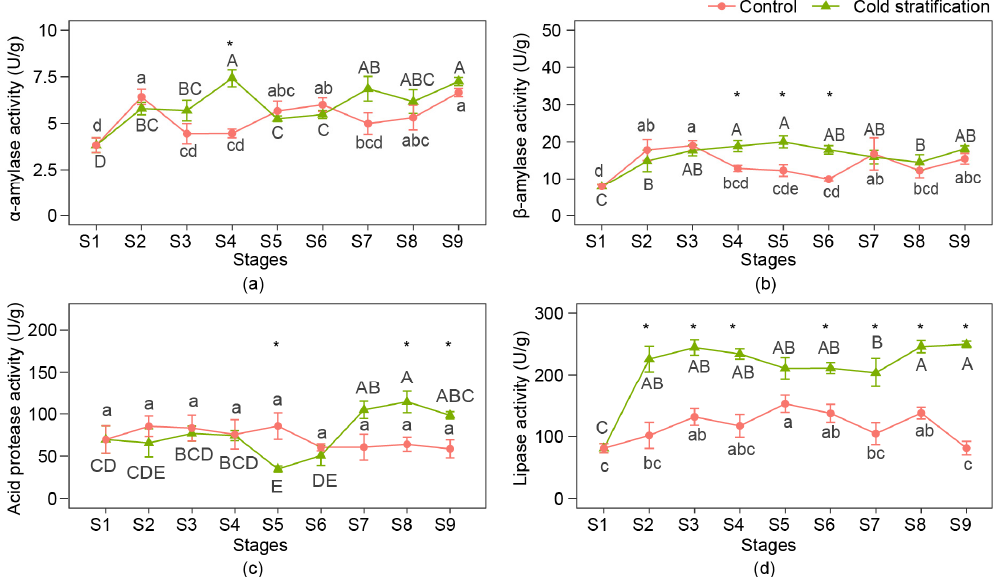
Figure 3. Enzyme activities related to nutrient consumption of P. emodi seeds during cold stratification. ( a ) α -amylase activity; ( b ) β -amylase activity; ( c ) acid protease activity; ( d ) lipase activity. Note: Lowercase letters represent the significance of differences between stages of control ( p < 0.05); capital letters represent the significance of differences between stages of cold stratification ( p < 0.05); * represents the significant difference between treatments at the same stage ( p < 0.05).